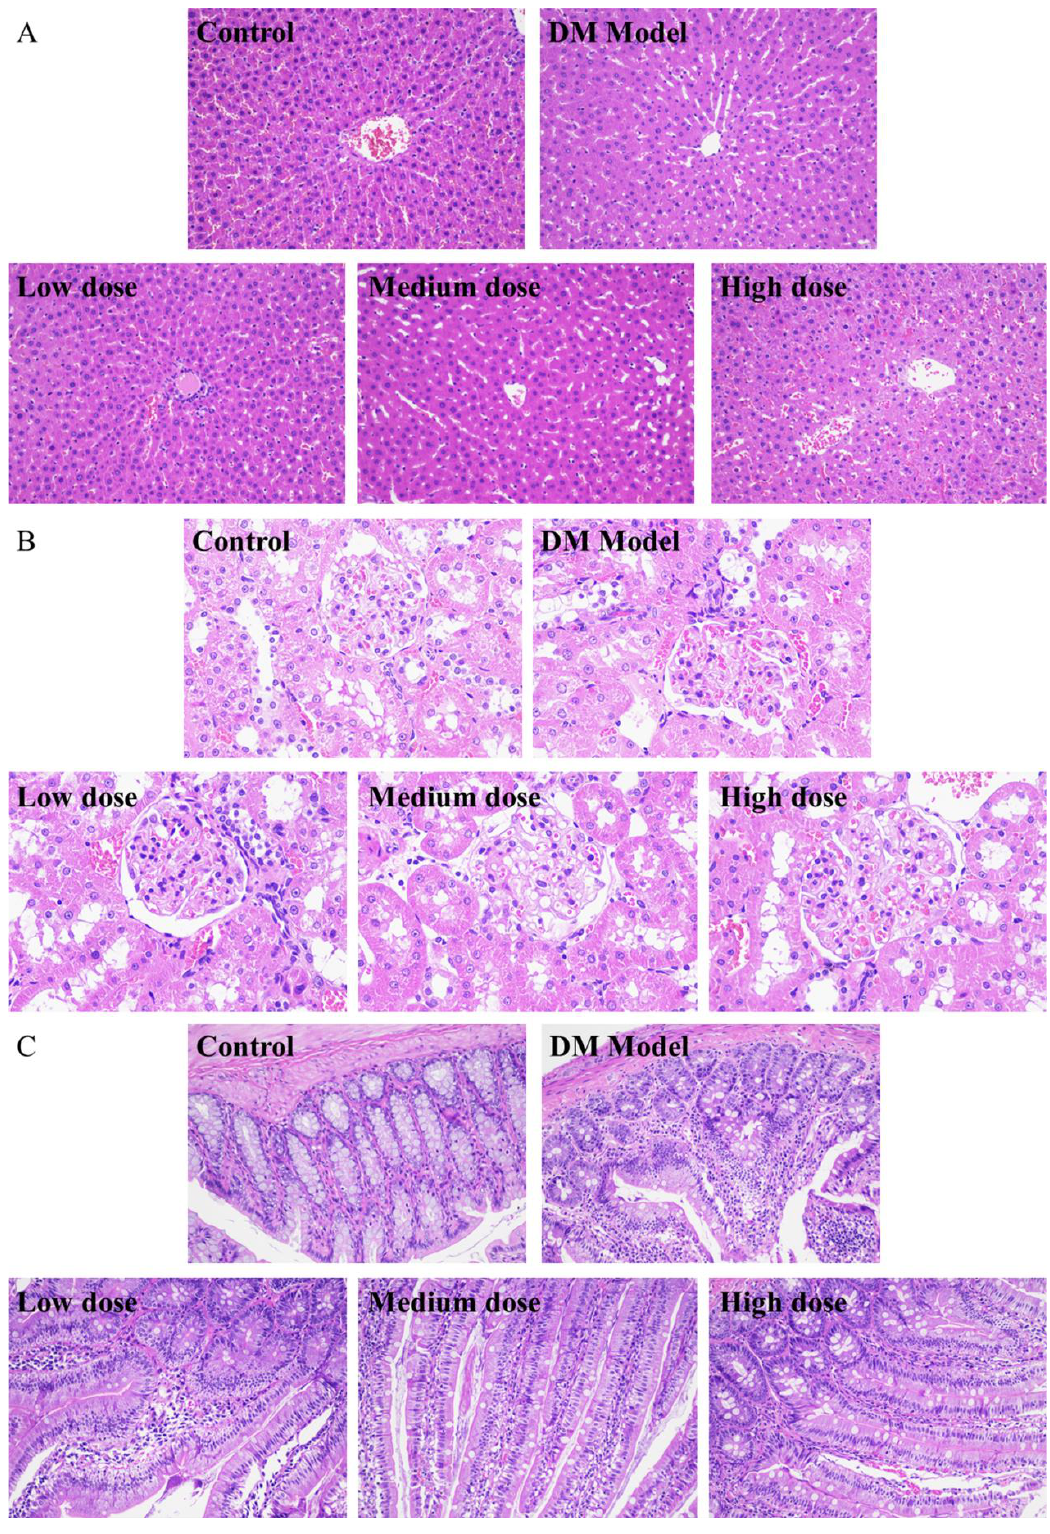
Figure 5. H&E staining sections of liver ( A ), kidney ( B ), small intestine ( C ) of the normal rats, untreated diabetic rats and diabetic rats treated by DC-5 at different doses for 30 days. All the samples for section preparation were collected on the 30th day of the gavage experiment. ( A , C ) were observed at 200× magnification. ( B ) was observed at 400× magnification.